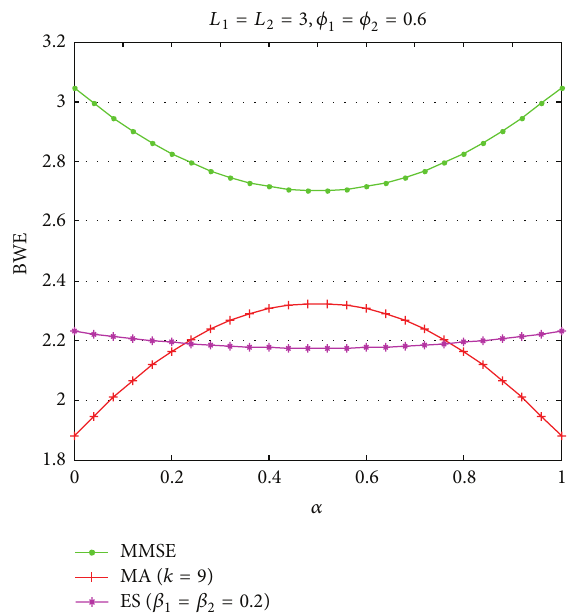
Figure 16: Comparison of three different forecasting methods by varying 𝛼 ( 𝑘 = 9 ).